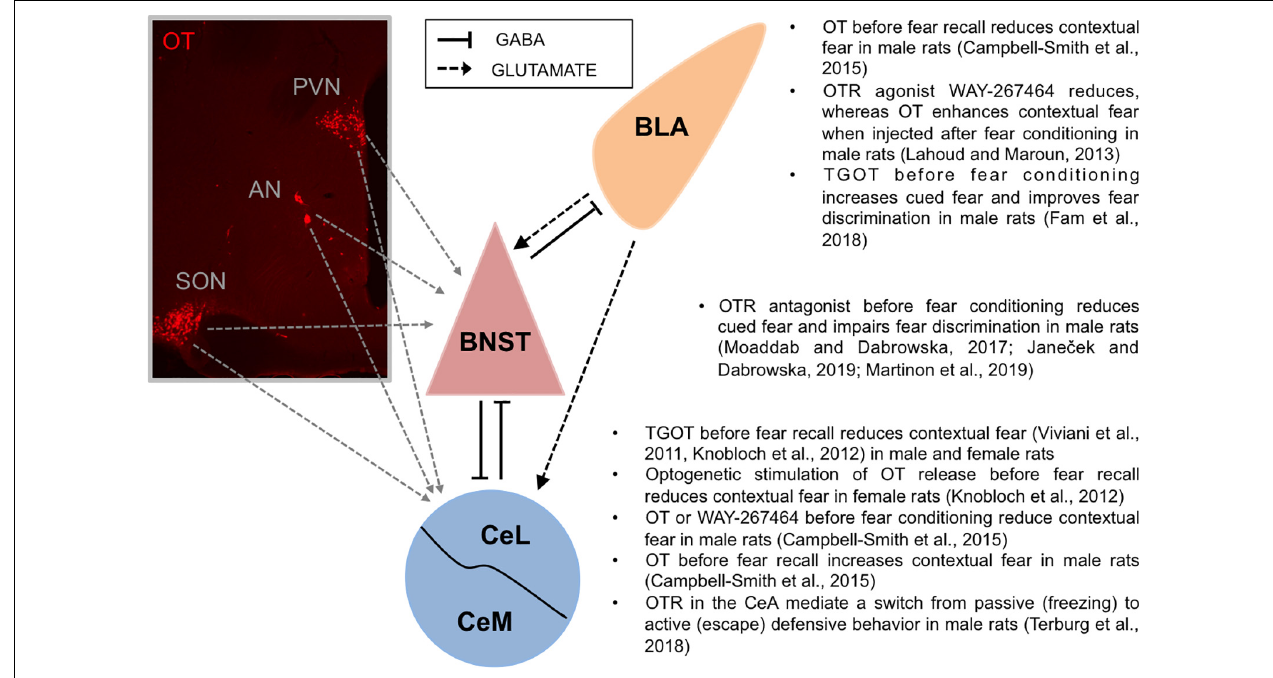
FIGURE 1 | Oxytocin fosters accurate fear discrimination. Left: Oxytocin neurons produced in hypothalamic nuclei (PVN, AN, and SON) project to the extended amygdala: the BNST and the CeA (Dabrowska et al., 2011; Knobloch et al., 2012; Martinon et al., 2019). Mouse monoclonal anti-oxytocin antibody (1:7500, MAB5296, Millipore-Sigma) was used to visualize oxytocin neurons in the hypothalamus. Right: Accurate fear discrimination can be defined as an ability to discriminate and primarily respond to cues predicting imminent threats while showing diminished fear responses to un-signaled, diffuse, or distant threats. In the CeA, OTR activation has been shown to improve fear discrimination by reducing contextual fear responses. In the BNST, OTR neurotransmission has been shown to improve fear discrimination by increasing fear responses to discrete cues (cued fear) and by attenuating fear responses toward un-signaled threats (non-cued fear). Similarly, in the BLA, OTR activation significantly improved discrimination between responses to threat-predicting cue (paired with shock, CS+) vs safety-predicting cue (un-paired CS-), by potentiating fear responses to the CS+. AN, accessory nucleus of the hypothalamus; BLA, basolateral nucleus of the amygdala; BNST, bed nucleus of the stria terminalis; CeL, lateral part of central amygdala; CeM, medial part of central amygdala; OT, oxytocin; PVN, paraventricular nucleus of the hypothalamus; SON, supraoptic nucleus of the